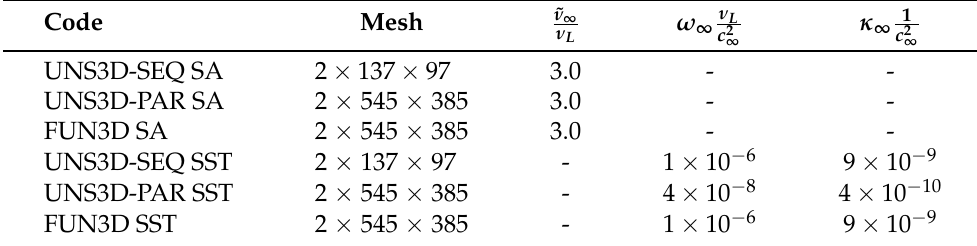
Table 3. Turbulent Boundary Conditions for Flat